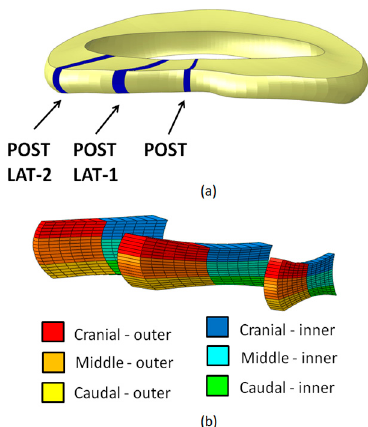
Figure 1. ( a ) Section of the annulus fibrosus in which the stress was analyzed; ( b ) division in subsections of the sections represented in ( a ).